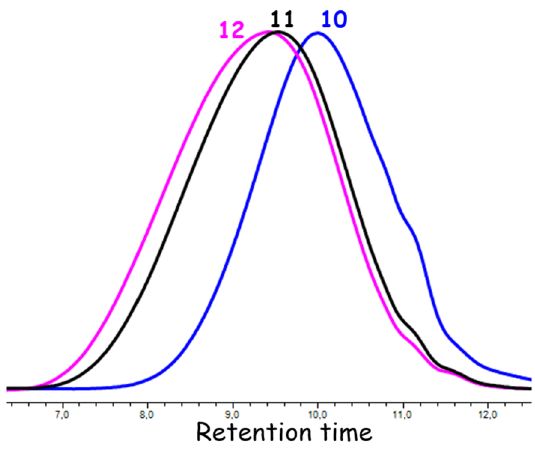
Figure 5. GPC curves obtained in experiments 10 —L-PPSQ synthesis; 11 —synthesis after first decompression; 12 —synthesis after second decompression.